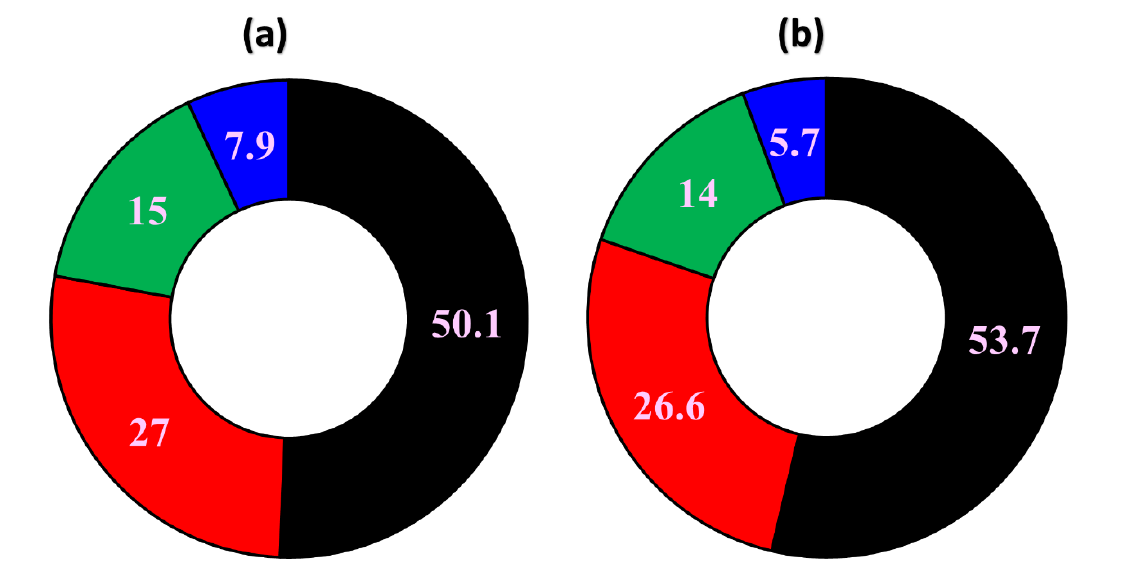
Figure 8. ( a ): Percentage contributions of the interaction of an atom present inside the HS to all the atoms present in the surroundings of the HS for CdMOF. ( b ): Percentage contributions of the interaction of all the atoms present inside the HS to an atom outside the HS for CdMOF.